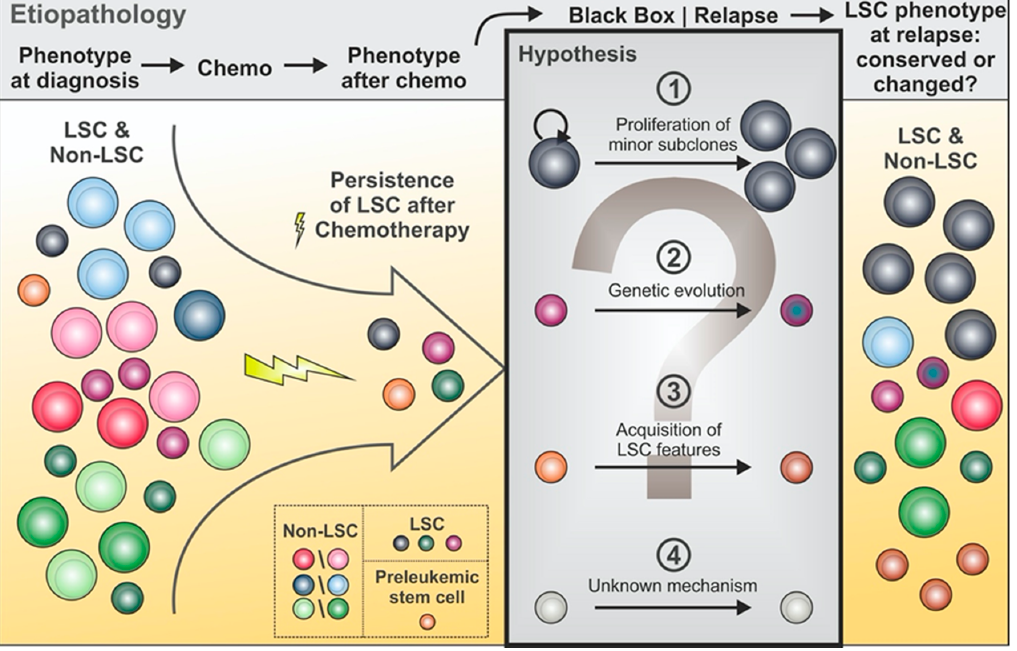
Figure 2. AML evolution and LSC heterogeneity after therapy. At diagnosis, various leukemic (sub)clones with corresponding LSC and non-LSC subpopulations may co-exist next to healthy and pre-malignant HSPC. Sensitivity to treatment varies between such cells, resulting in the elimination of non-LSC and potentially selection of (sub)clones and their corresponding LSC. Relapse may be driven by persistent LSC from the main (sub)clone(s) or from LSC from minor subclones that at diagnosis remained undetectable but then grow out to drive relapse. Furthermore, genetic evolution might occur conferring growth advantages to LSC and perhaps changing their surface phenotype. Finally, new leukemic clones can develop through acquisition of further mutations in the pre-malignant HSPC; disease "relapse" is in this case driven by de novo leukemic